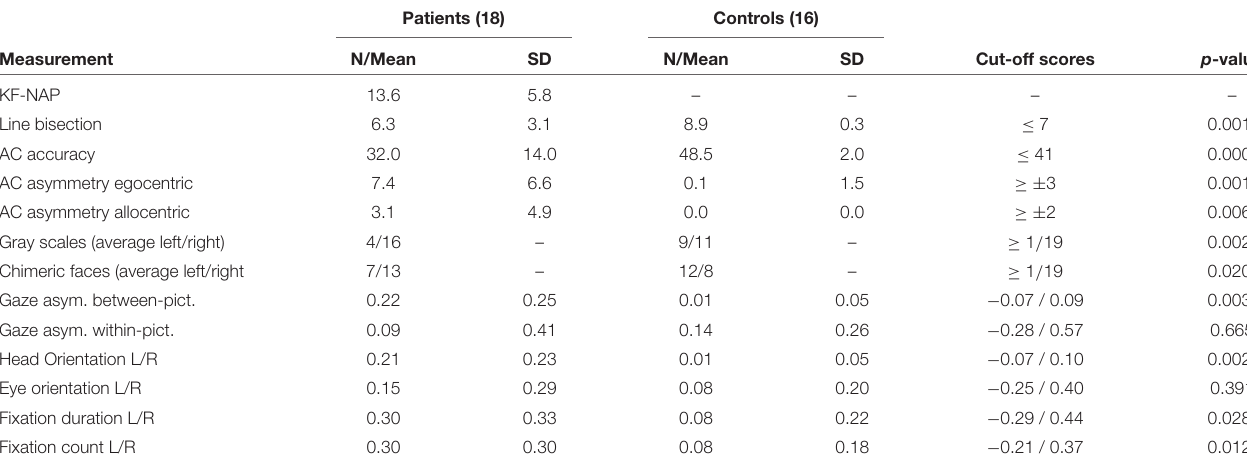
TABLE 3 | Group-level reports for patient and control groups (conventional and VR tests).